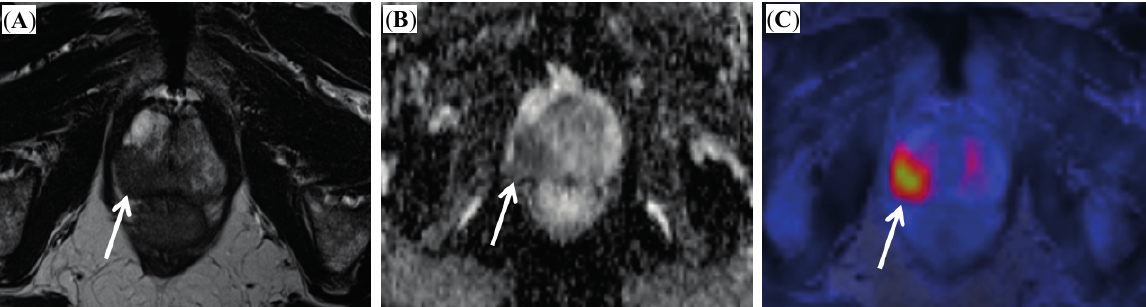
Figure 2. Patient with biopsy proven prostate carcinoma (Gleason score 4 + 3 = 7). ( A ) T2-weighted image presenting a hypo-intense lesion of the right peripheral zone; ( B ) ADC map indicating restricted diffusion within the tumor; ( C ) Fused PET/MR image depicting pathologically increased choline uptake of the tumor. (Arrows indicate prostate